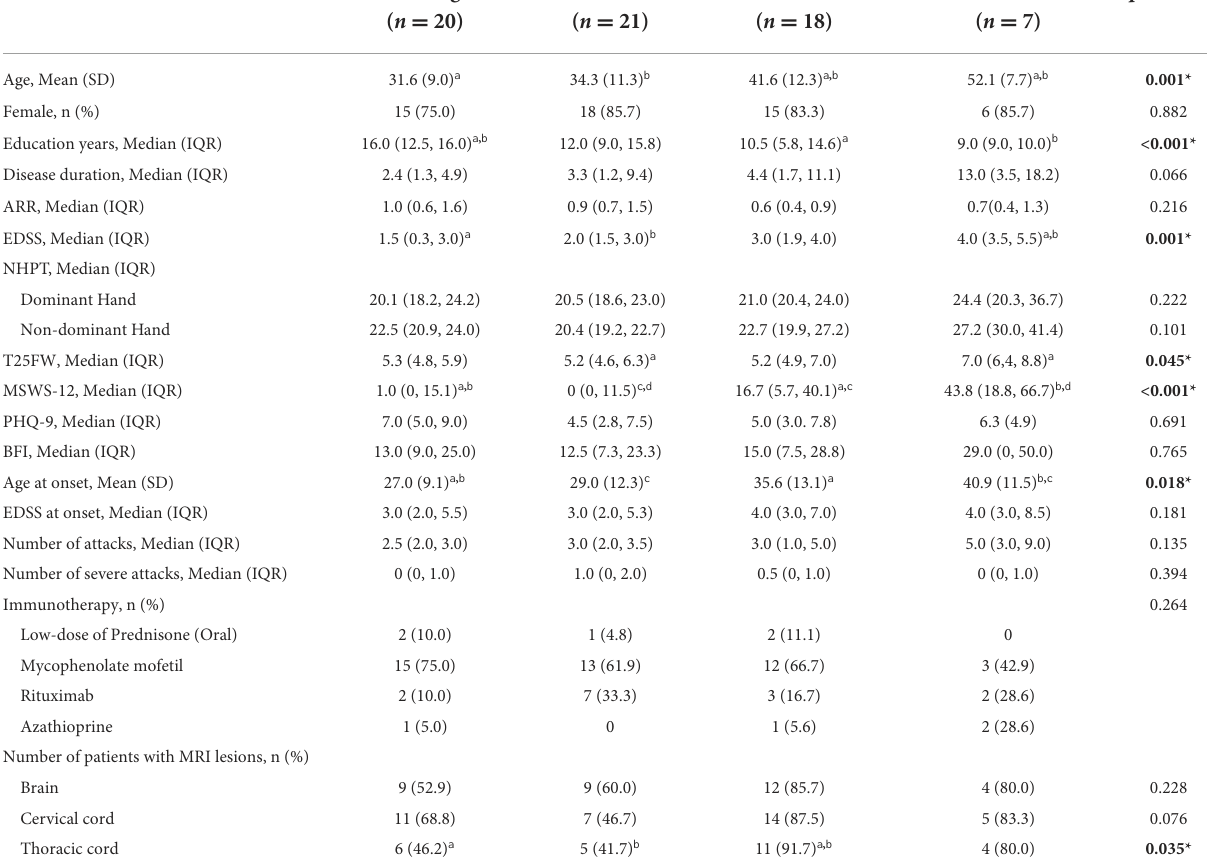
TABLE 2 The demographic and clinical characteristics of the four cognitive phenotypes. Variables